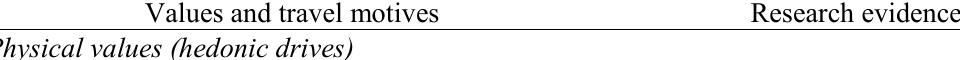
Physical and emotional